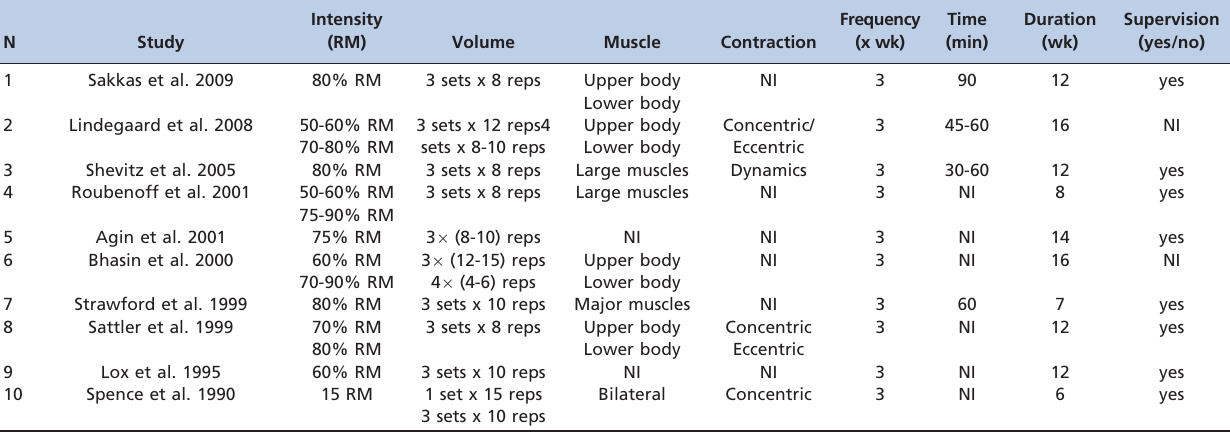
Table 3 - Characteristics of the experimental intervention (resistance exercise) the trials included in the review.